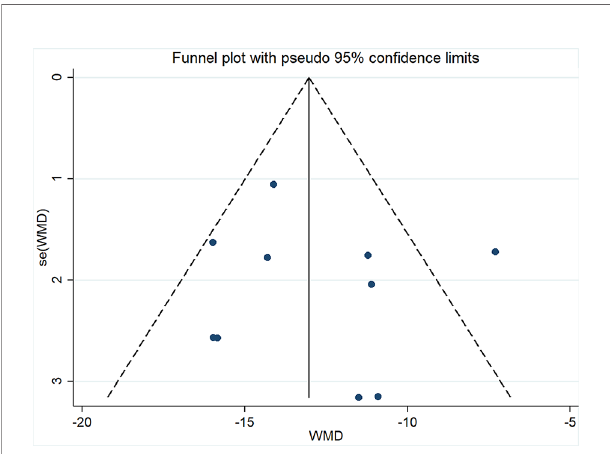
FIGURE 4 | Funnel plot for publication bias of mALB.